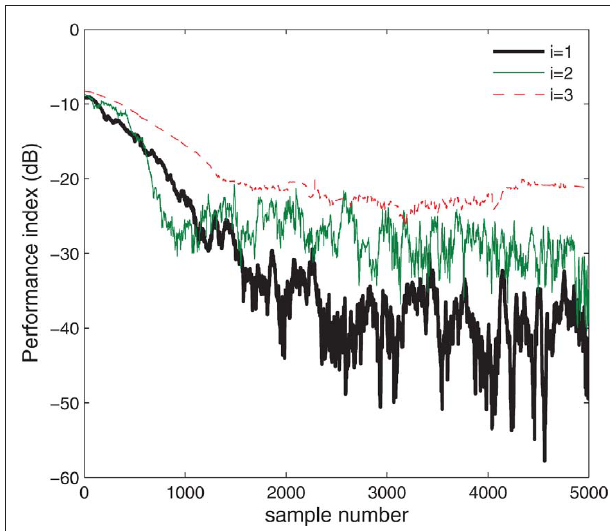
( k ), s ( k ), and s ( k ). The 1 2 3